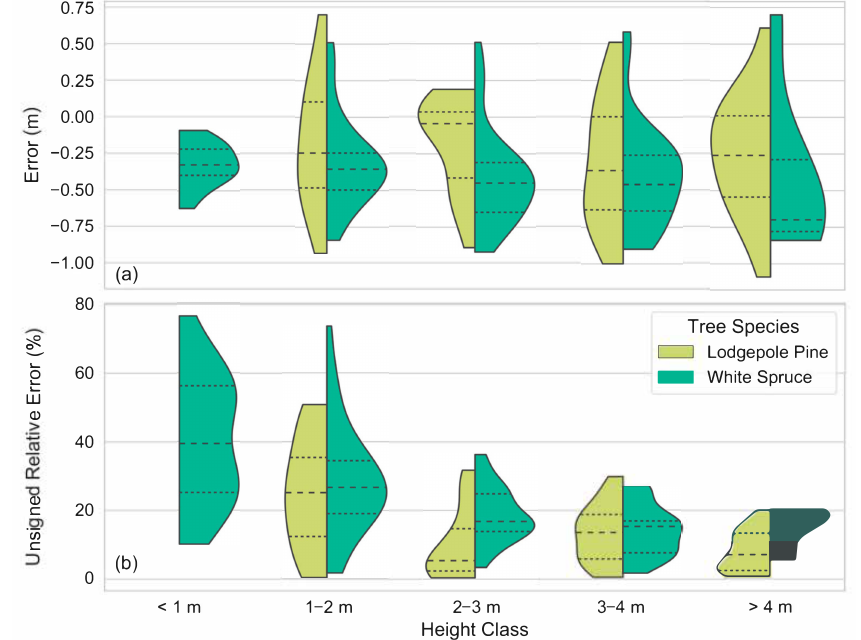
Figure 10. Remote height measurement error ( a ) and unsigned relative error ( b ) for conifers at the individual tree level, stratified by height class intervals. The first and third quartiles of each height class distribution are demarcated with short dashes, while class means are demarcated with long dashes. There were no lodgepole pine samples below one metre in height. A total of 194 conifers (67 lodgepole pine and 127 white spruce) were